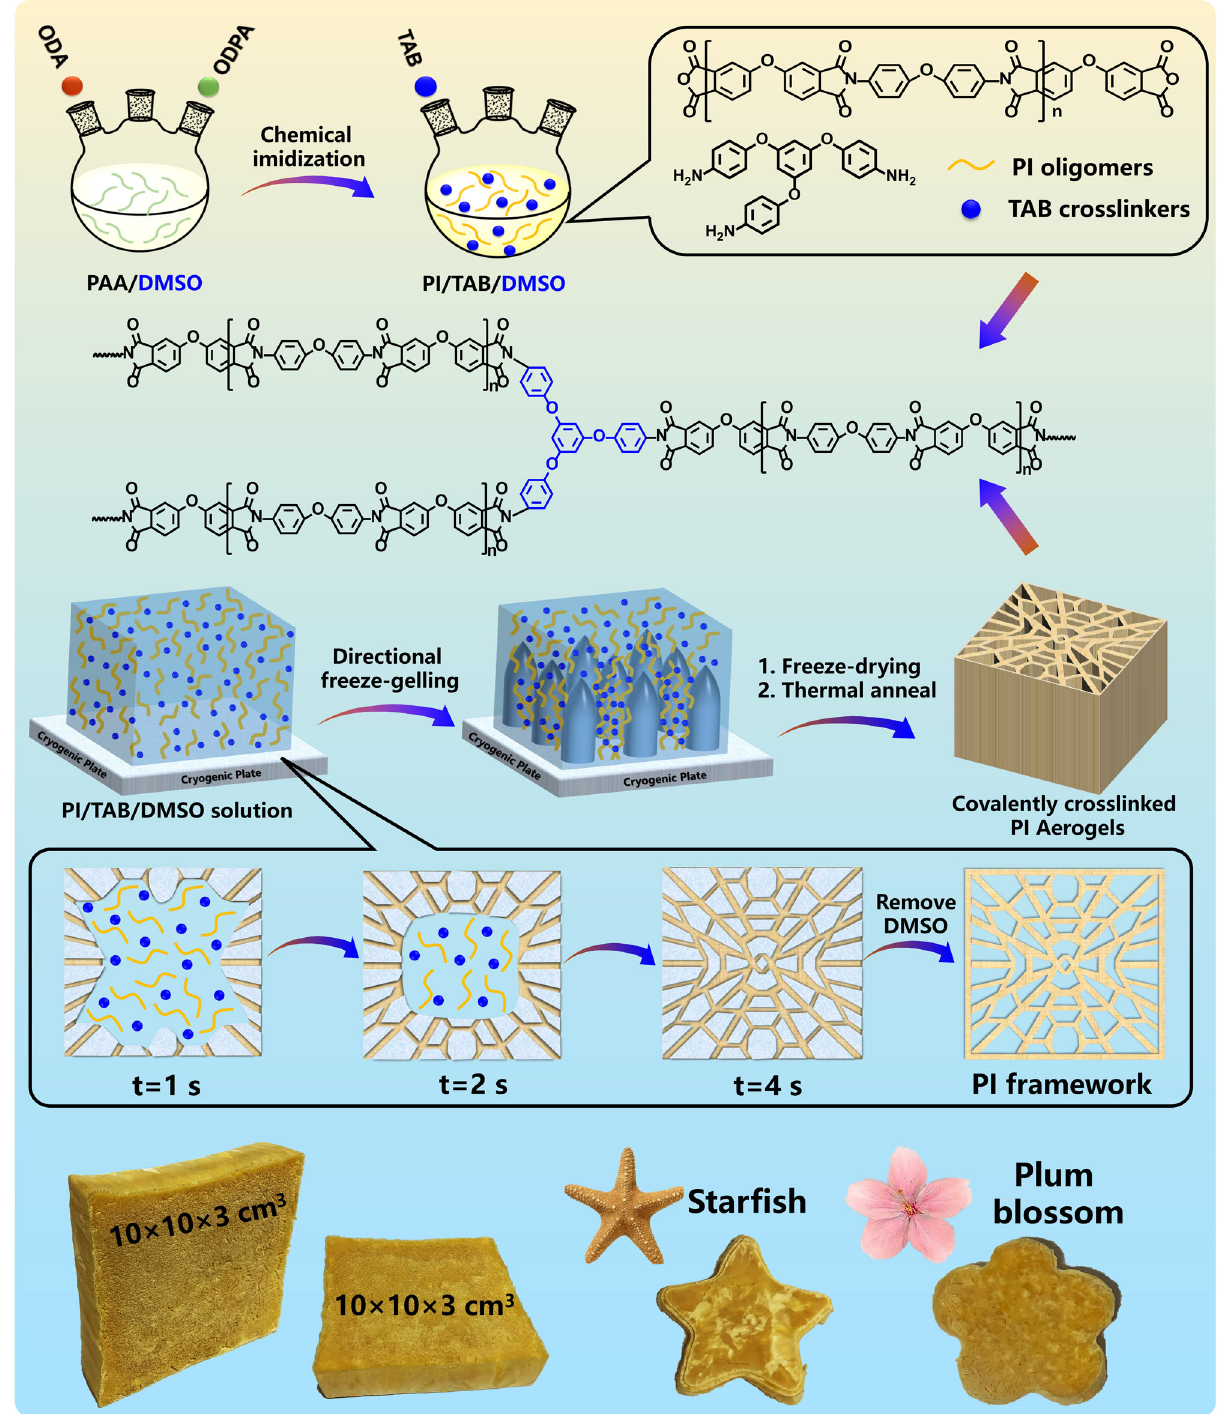
Fig. 1 Schematic illustration of constructing super-elastic PI aerogels. Design and synthesis of PI aerogels with covalent crosslinking, radially distributed cellular structure, and diversely shaped bulk